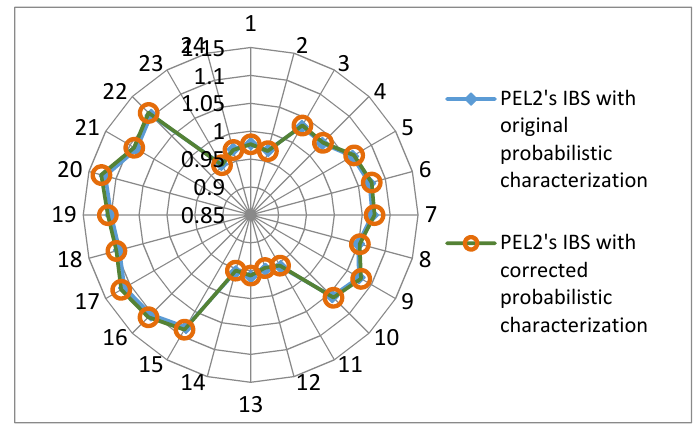
Figure 13. Interaction benefit satisfaction (IBS) of PEL 2 with changing